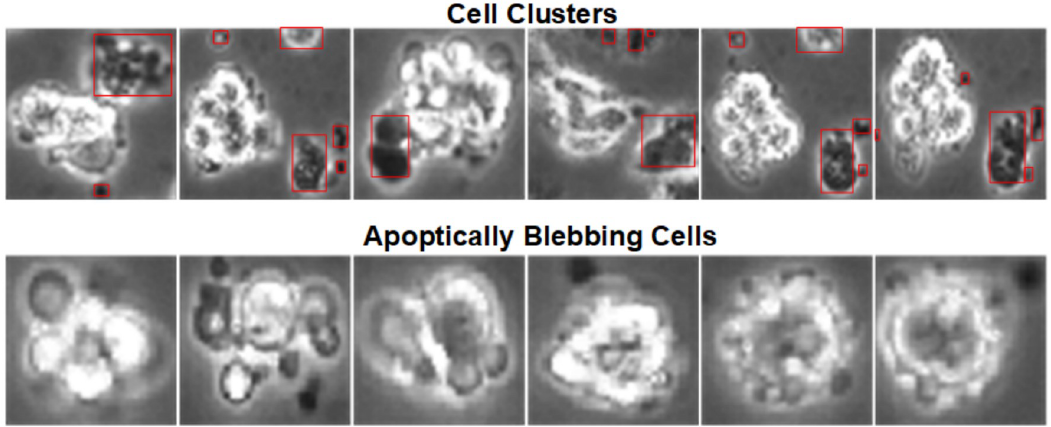
Fig 3. Example images of Cell clusters and Apoptically Blebbing cells . The distinguishing features between Cell clusters and Apoptically Blebbing cells are the small cells in the Cell clusters packed close to each other.